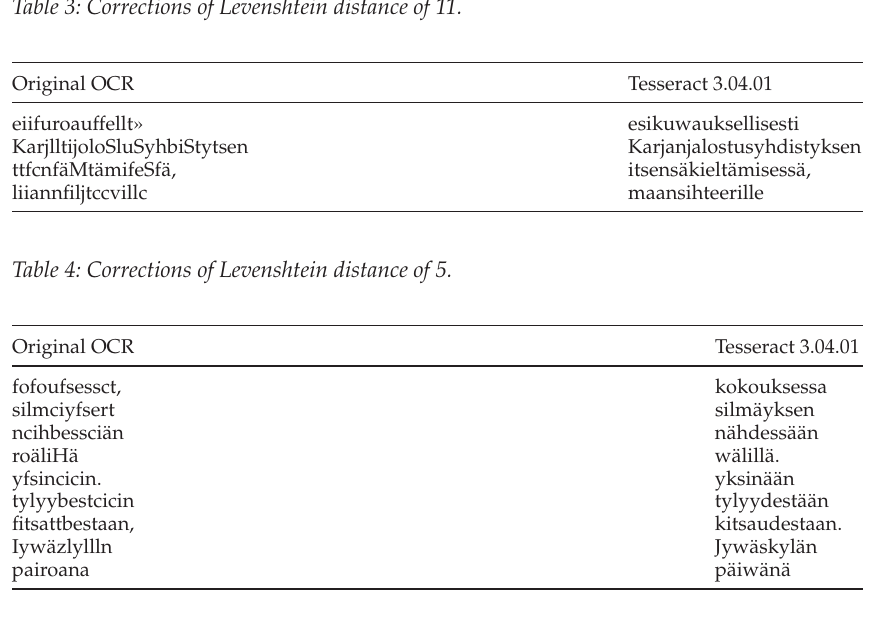
Table 3: Corrections of Levenshtein distance of 11.